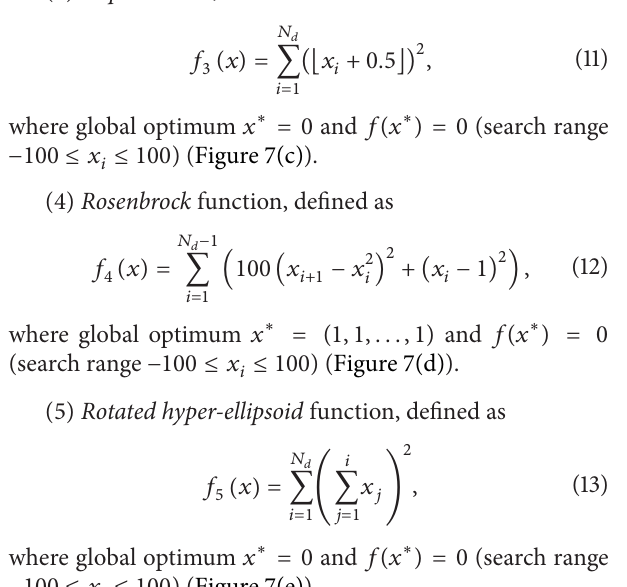
Most of the benchmark functions have standard